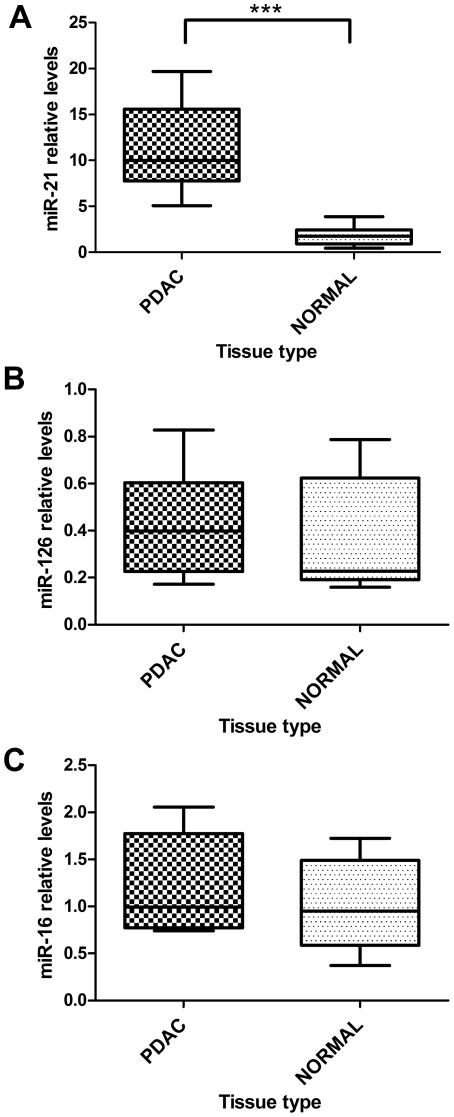
RT-qPCR of selected miRNAs performed on fresh tissues.(A) miR-21, (B) miR-126 and (C) miR-16 were measured using RT-qPCR in order to compare PDAC to normal pancreas for the miRNAs of interest. MiR-21 is overexpressed in PDAC compared to normal pancreas tissue (*** P<0.001). MiR-126 and miR-16 expression levels were not significantly different between PDAC and normal pancreas tissue. Samples included: normal pancreas (n = 9) and PDAC (n = 15). Box and Whiskers indicate median, minimum and maximum.